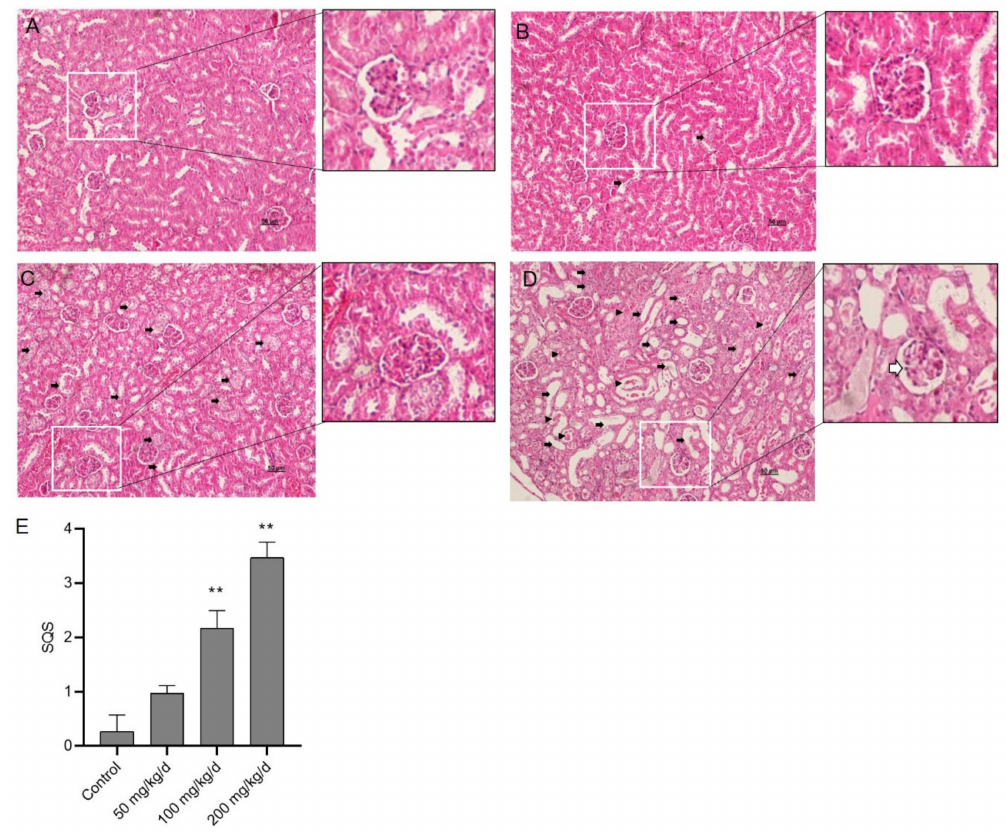
Figure 2. Representative histopathological changes in kidneys of mice and the semi-quantitative scores (SQSs). ( A ) Control group: no significant damage. ( B ) CuSO 4 50 mg / kg / day group: mild damage. ( C ) CuSO 4 50 mg / kg / day group: intermediate damage. ( D ) CuSO 4 200 mg / kg / day group: extensive damage. ( E ) SQSs are presented as the mean ± SD ( n = 3). ** p < 0.01, compared to the control group. Filled arrows indicate tubular degeneration, necrosis and tubular dilation, arrowheads indicate cast formation, and the open arrow indicates glomerular abnormalities. Hematoxylin–eosin staining. Bar = 50 µ m.